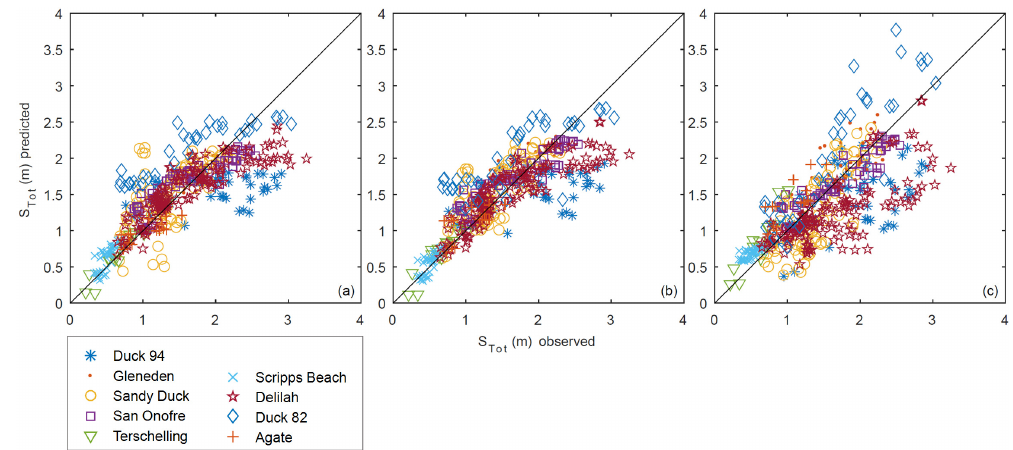
Figure 4. Observed versus predicted S Tot using (a) GP Eq. (11), (b) GP Eq. (12) and (c) Stockdon et al. (2006) Eq. (5) for the original data set (Stockdon et al., 2006). This is not a test of any predictor, only a consistency check – all data were shown to the GP algorithm and used to generate the linear regression in (c)